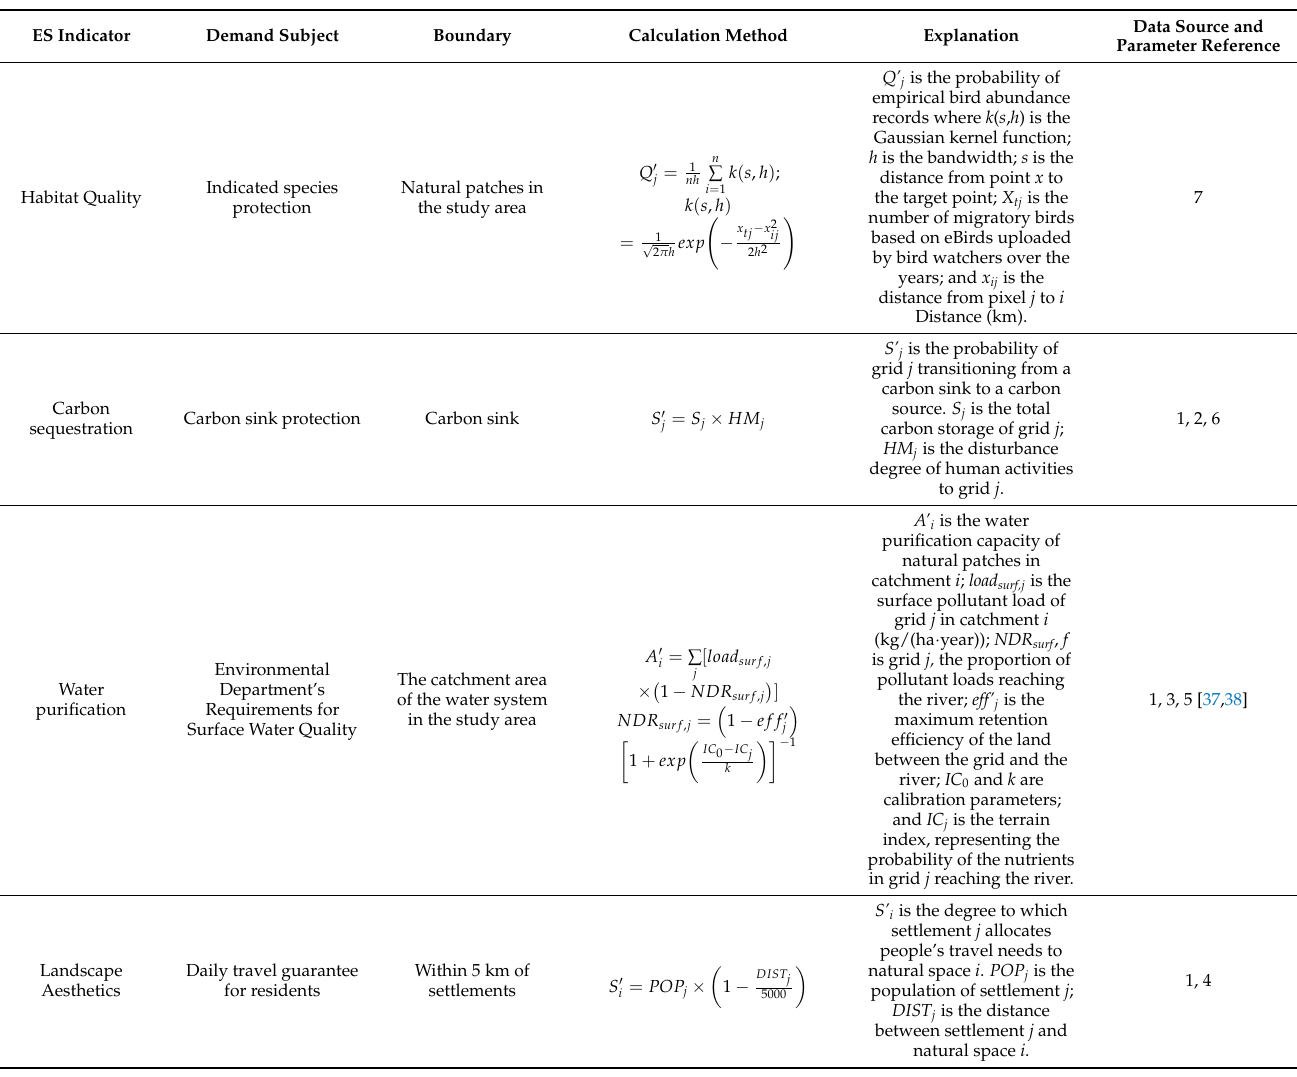
Table 2. Ecosystem service demand allocation and quantification